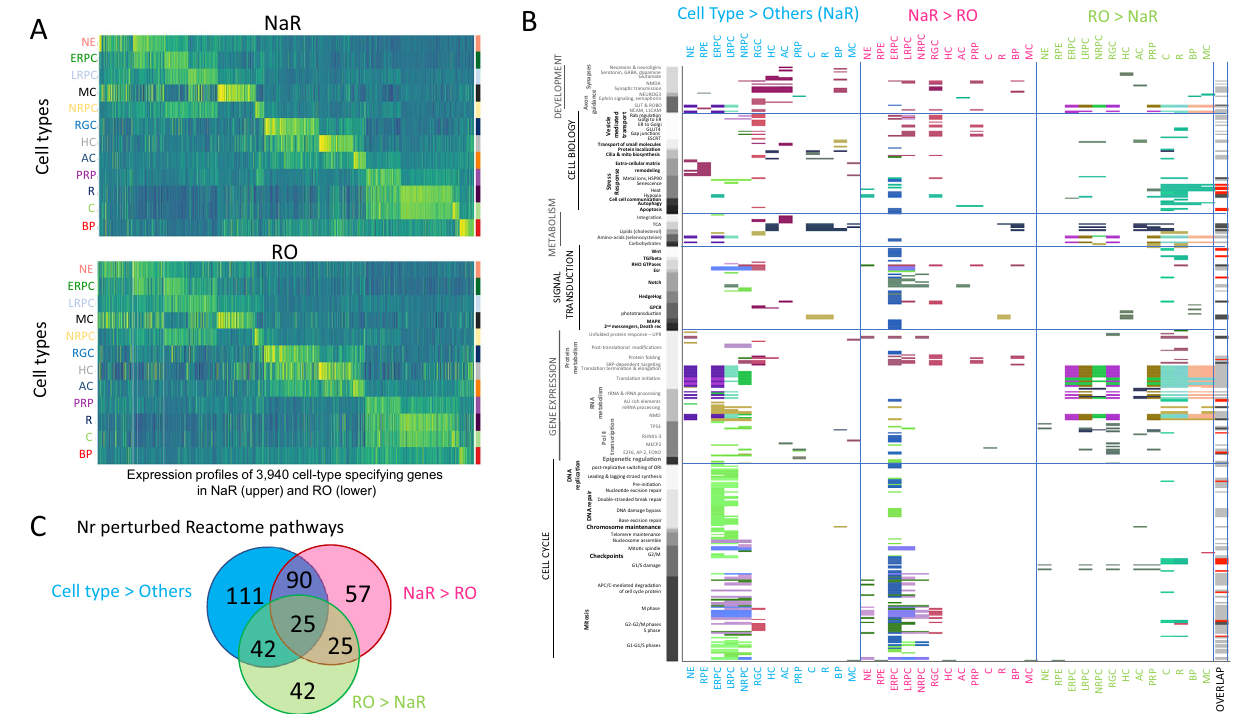
Figure 3. Comparison of the cell type-specific transcriptome of NaR and RO by means of scRNA-Seq. ( A ) Expression profiles in 13 cell types of 3940 genes that are dynamically regulated during in vivo retinal development (i.e. significantly overexpressed in at least one cell type when compared to all other ones in NaR) in NaR (upper panel) and RO (lower panel). Abbreviations refer to cell types and are as defined in Fig. 1. ( B ) Reactome pathways that are significantly (p ≤ 0.001) enriched amongst differentially expressed genes (“Cell type > Others”: when comparing expression levels between specific cell types and all other cells in NaR; “NaR > RO” and “RO > NaR”: when comparing expression levels between NaR and RO cells within cell types). Reactome pathways (Y-axis) are sorted by “top level” pathway (cell cycle, gene expression, signal transduction, metabolism, cell biology and development) and sub-level therein. Colored tiles highlight the pathways that are significantly enriched in the corresponding comparisons (“Cell type > Others”, “NaR > RO” or “RO > NaR”). The colors of the tiles reflect similarity in the sets of Reactome “found entities” as described in the main text and Fig. S5. The last column (“Overlap”) shows the overlap between Reactome pathways enriched in cell type- specifying genes versus genes that are differentially expressed between NaR and RO: White: pathways significant in only one of the three comparisons, Black: pathways significantly different in all three comparisons, Grey: pathways significant in “Cell type > Others” and either “NaR > RO” or “RO > NaR”, Red: pathways significant in both “NaR > RO” and “RO > NaR”. ( C ) Number of unique and shared Reactome pathways between “Cell type > Others”, “NaR > RO” and “RO > NaR”. All overlaps are highly significant (p < 10 –6